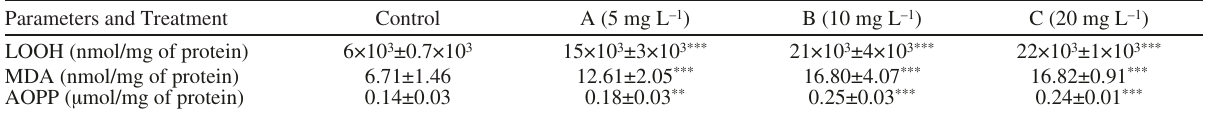
Table 1. – MDA LOOH and AOPP levels in Mactra stultorum gills of control and specimens treated with graded doses of ACR (5, 10 and 20 mg L –1 ) after five days of treatment.Values were expressed as means ±SD. The number of determinations was n=8. Groups A, B and C vs.